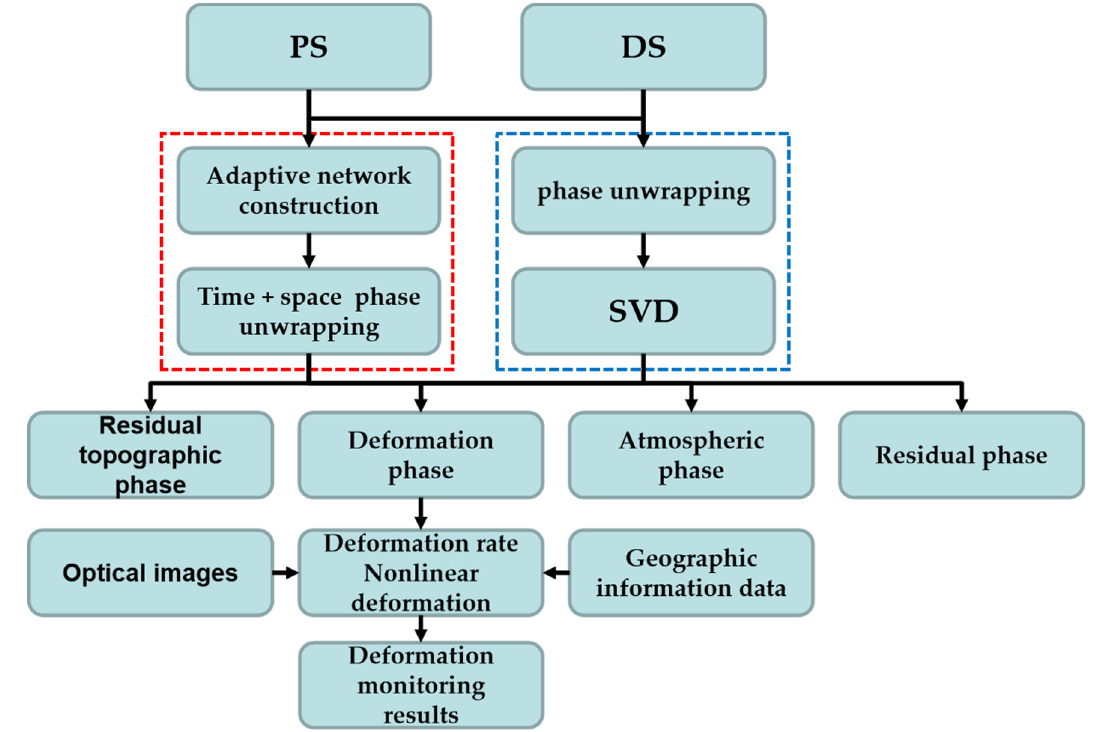
Figure 4. SAR processing flow, indicating the processing flow from obtaining PS/DS points to obtaining deformation.